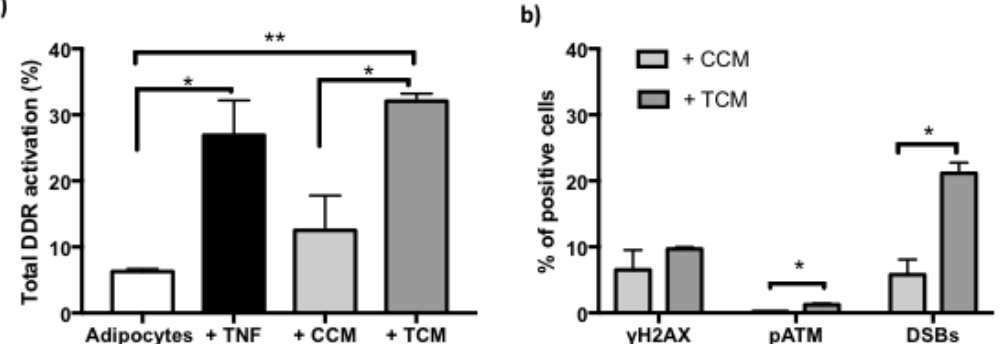
Figure 8. Sustained DNA Damage Response (DDR) activation vs. basal. ( a ) Increased percentage of DNA damage response activation in adipocytes treated with TNFα (125 ng/mL, 24 h), and after adipogenesis in conditioned control medium (+ CCM) or treated control medium (+ TCM). Three independent experiments with experimental replicates were carried out. Multiple comparison analysis ANOVA * p < 0.05, ** p < 0.001 ( b ) Increases in the percentage of positive cells distribution of pATM and DSBs after adipogenesis with medium conditioned treated (+ TCM). Three independent experiments were carried out. One-way ANOVA test * p < 0.05.